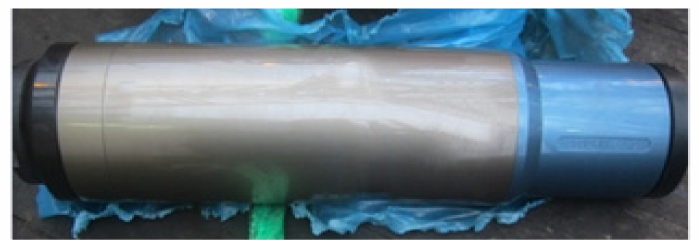
Figure 2. Composite impactor appearance dimensions.